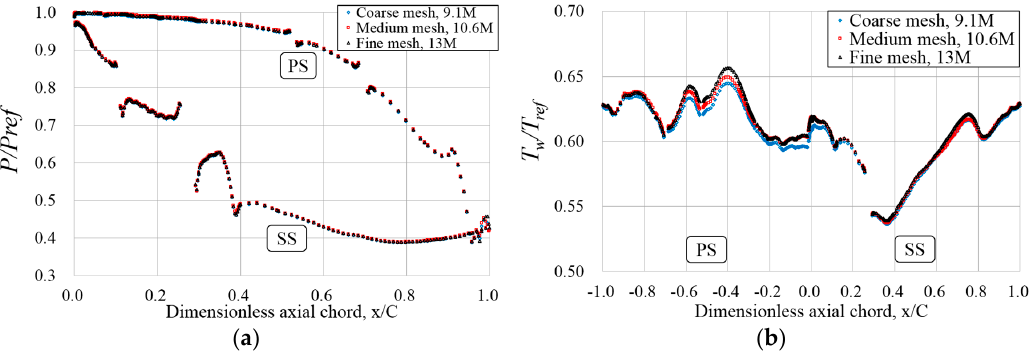
Figure 3. ( a ) Pressure; ( b ) temperature distributions of three meshes at midspan.